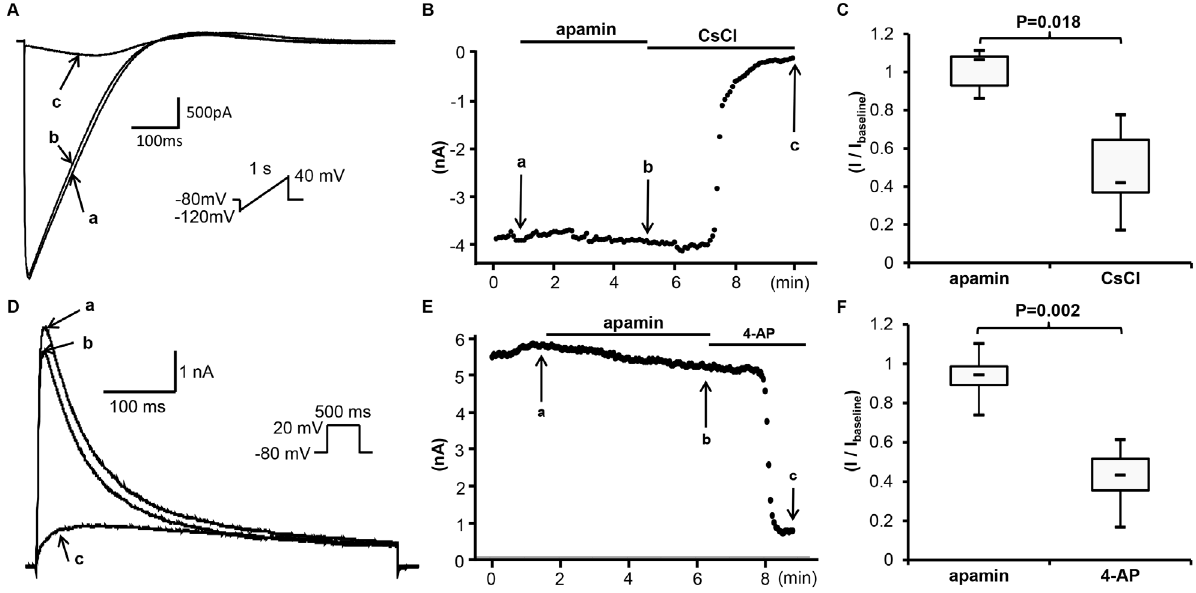
Figure 6. Effects of apamin on I K1 and I to in transfected HEK 293 cells. (A) The representative tracings of I K1 by ascending voltage ramp protocol shown in the inset before apamin (a), after apamin (b) and after CsCl (c) at time points indicated by arrows a through c, respectively, in (B). (B) The time course of I K1 at –100 mV. (C) The summary of drug effects normalized to baseline. (D) The representative tracings of I to obtained by a pulse protocol shown in the inset before apamin (a), after apamin (b) and after 4-AP (c) at time points indicated by arrows a through c, respectively, in (E). (E) The time course of peak I to at 20 mV. (F) The summary of drug effects normalized to baseline.